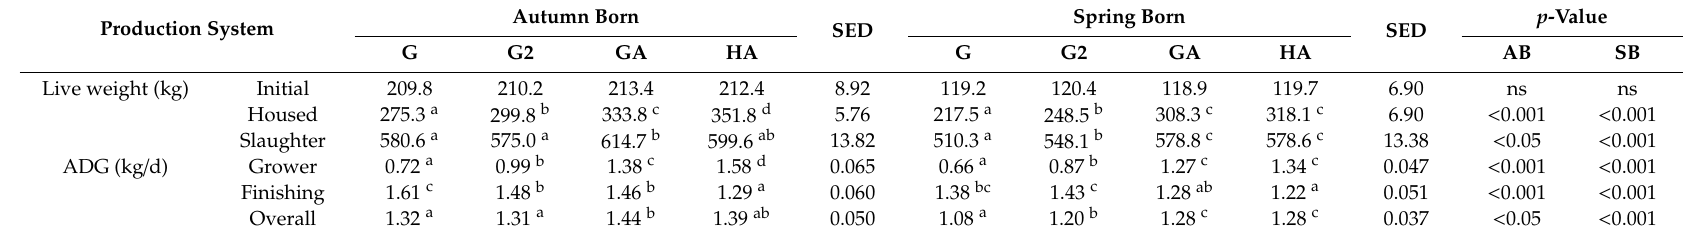
Table 4. Mean performance of autumn and spring born bulls on four production